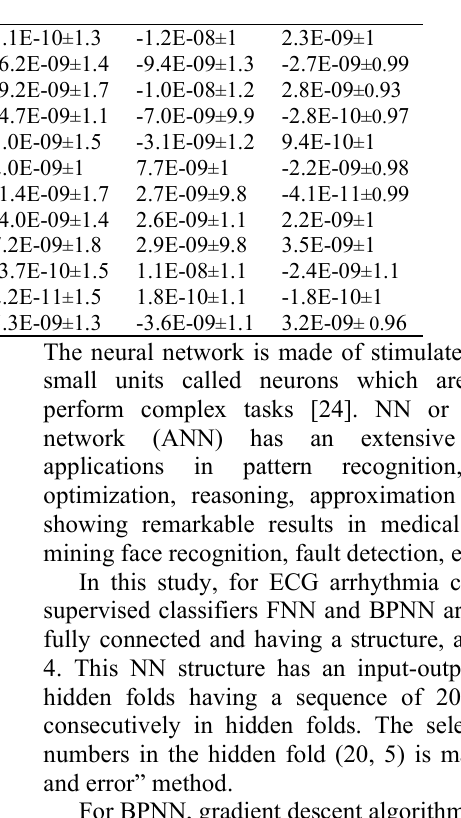
Table 3. Twelve kernel independent coefficients extracted from 130 data points of samples of a single beat Normal Feature (KICA)